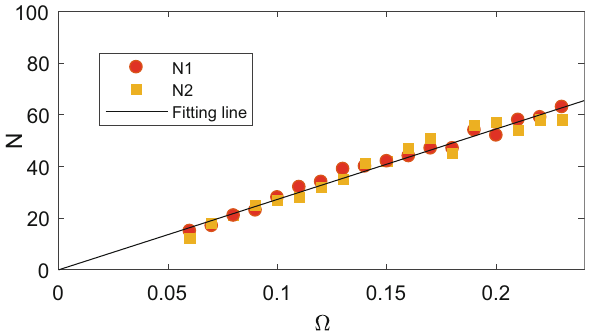
Fig. 7 Vortex number of both components vs. angular velocity Ω .